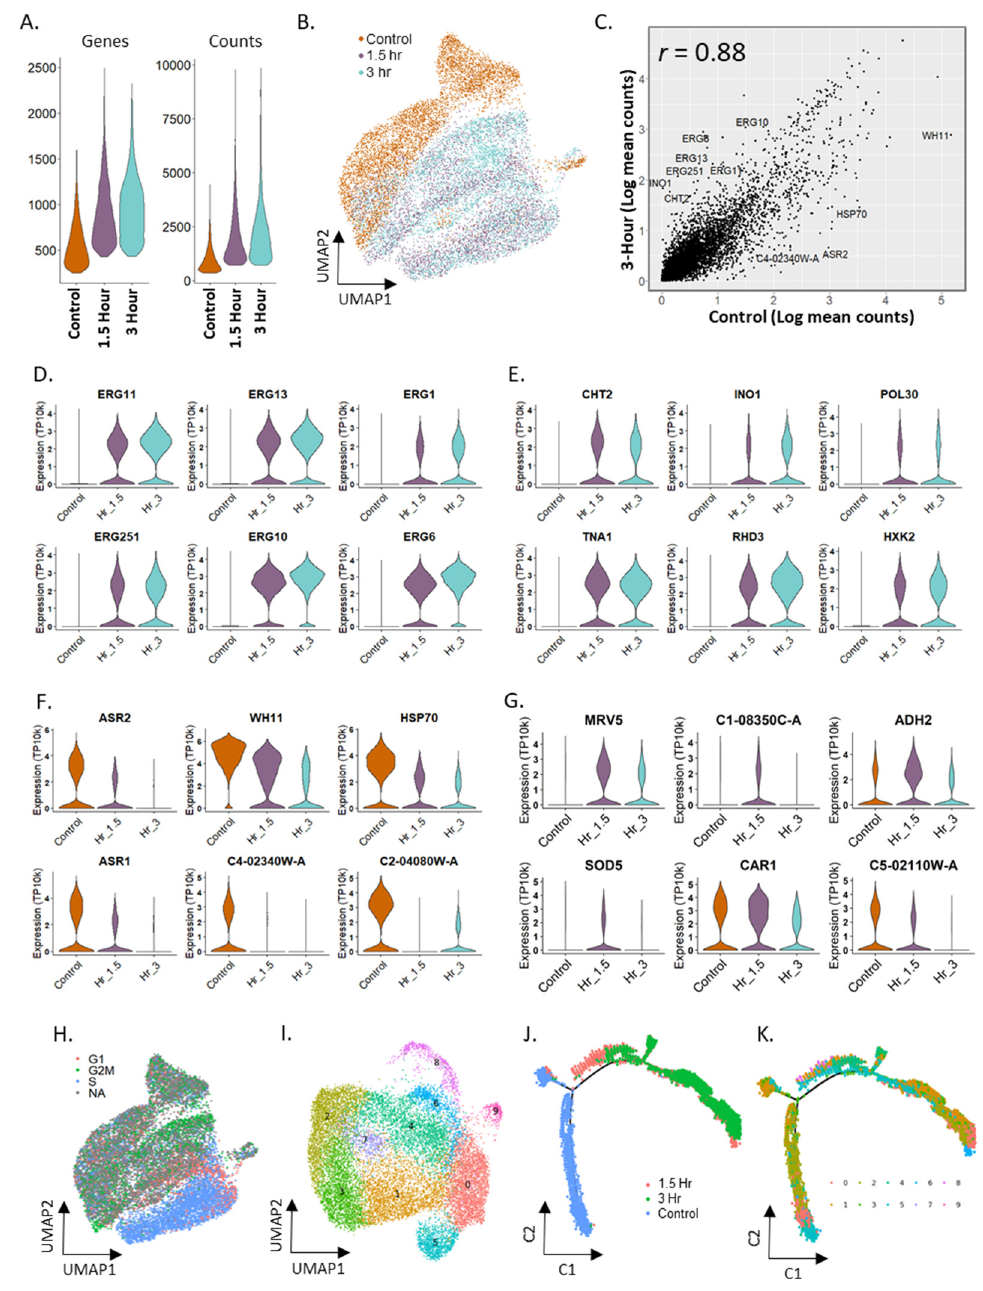
Figure 4. Fluconazole treatment of 15,503 Candida albicans cells profiled using mDrop-seq. ( A ) Num- ber of genes and UMI for each fluconazole treatment times. ( B ) UMAP displaying the clustering of the combined control and fluconazole data. ( C ) Correlation between the control and 3 h fluconazole exposed yeast for gene expression. ( D ) Violin plots displaying expression in control and fluconazole datasets for several ergosterol biosynthesis genes. ( E ) Violin plots displaying the expression differ- ences of genes detected at significantly higher expression in fluconazole treated data. ( F ) Violin plots of gene expression show significantly higher expression in the control data. ( G ) Violin plots of DEGs for the 1.5 h fluconazole exposed data. ( H ) Cell cycle assignment on the integrated control and flu- conazole data. ( I ) UMAP of the integrated data after cell cycle regression. ( J – K ) Pseudo-time trajec- tory of the combined data inferred using Monocle. Colors indicate: ( J ) experimental time-points, and ( K ) cell-type clusters shown in I.